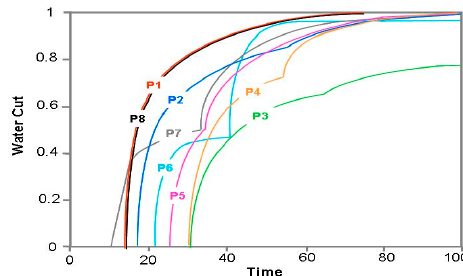
Figure 3. Water-cut (fraction) in individual producer wells (P1 to P8) versus non-dimensional time. Kink in curves for producers P2 to P7 is due to, and diagnostic for, the arrival of the flood front from a second injector well, connected to these producers. Computed using CAM. Reproduced with permission from [3].